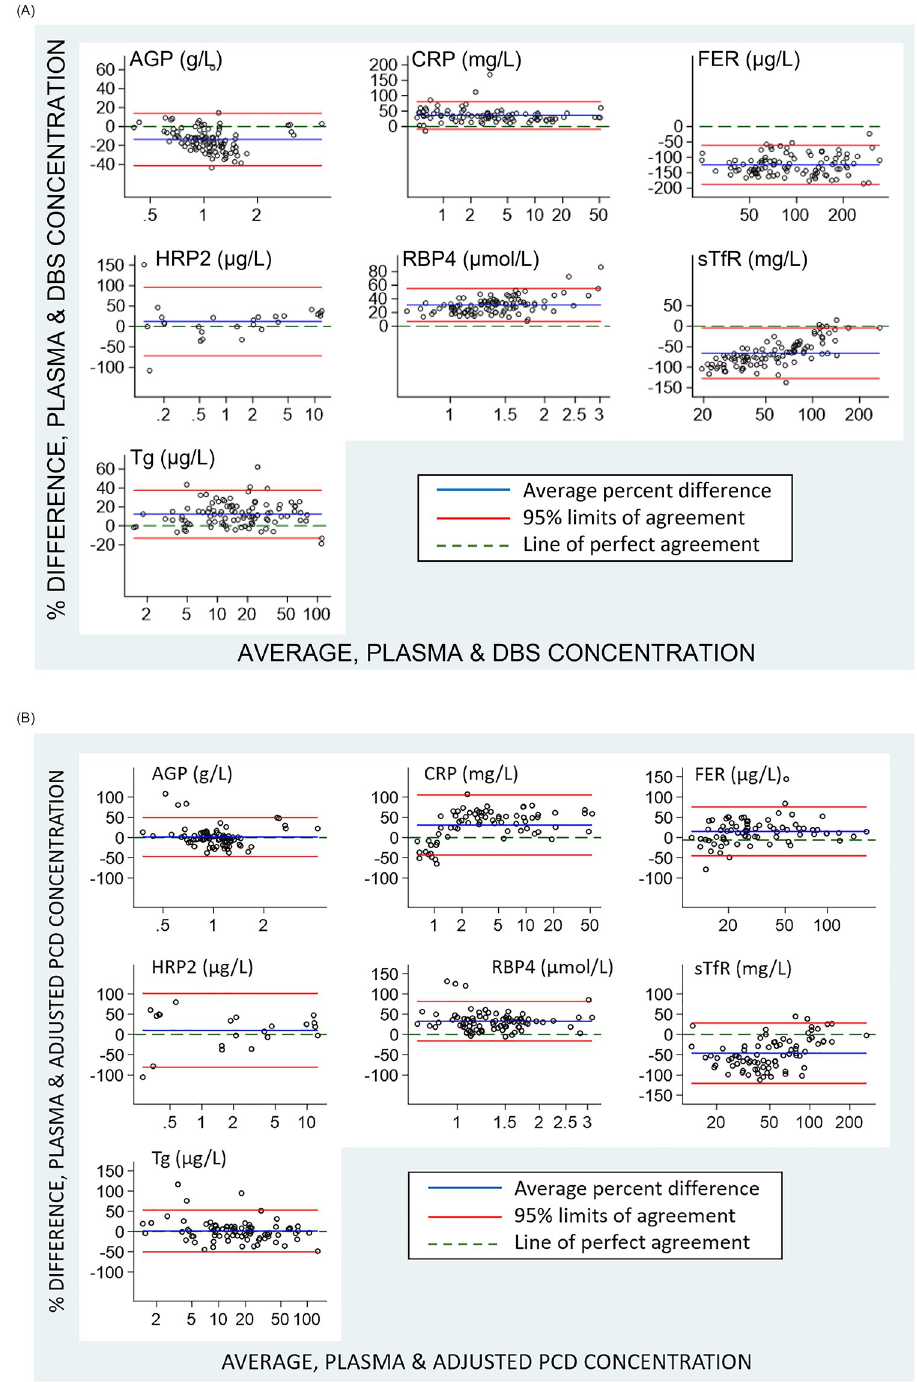
Fig 4. A . Bland Altman plots of the difference in results derived from wet plasma versus DBS types measured using the 7-plex assay. Average of the wet plasma and dry sample type (x-axes) are plotted against the difference between measurements from the 7-Plex assay for paired wet plasma and dry sample types (y-axes). B . Bland Altman plots of the difference in results derived from wet plasma versus the adjusted PCD. For both Figures, the horizontal lines indicate line of perfect agreement (green), mean (purple), and ± 2standard deviations of the difference (red). AGP, α -1-acid glycoprotein; CRP, C-reactive protein; FER, ferritin; HRP2, histidine rich protein 2; RBP4, retinol binding protein 4; sTfR, soluble transferrin receptor; Tg, thyroglobulin; DBS, dried blood spot.